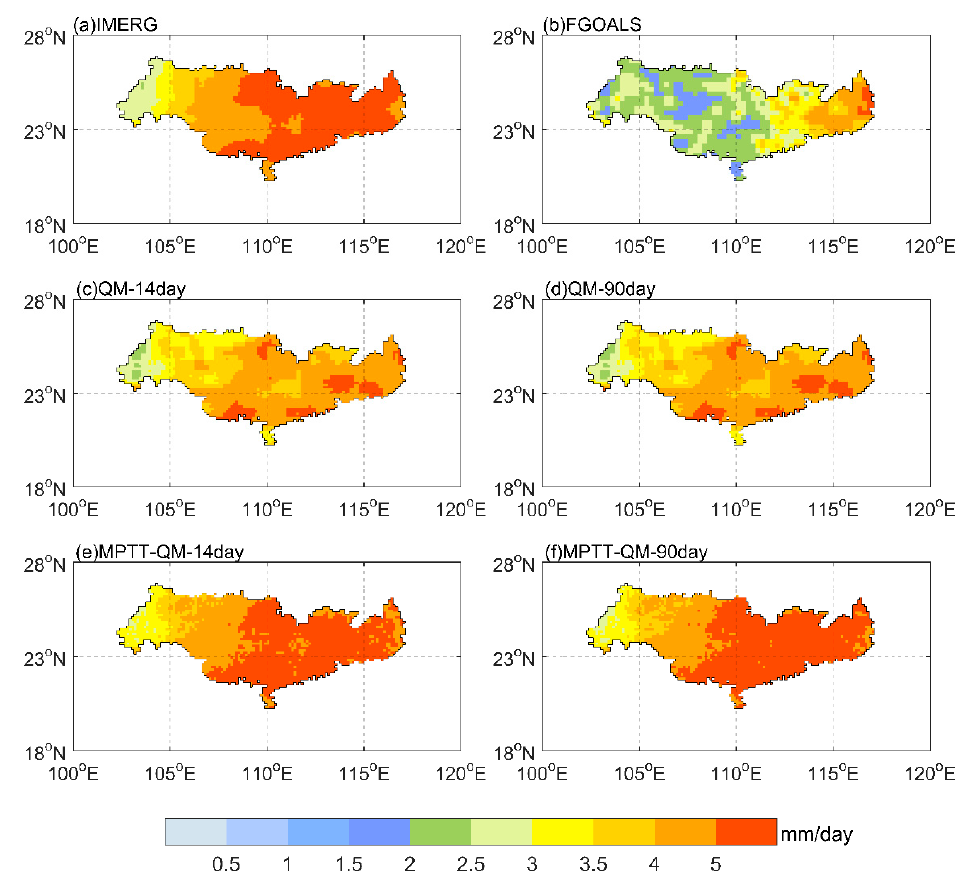
Figure 3. Spatial patterns of daily average precipitation from 2016 to 2020 in the PRB: ( a – f ) represent the IMERG, FGOALS, QM-14day, QM-90day, MPTT-QM-14day, and MPTT-QM-90day, respec- tively.